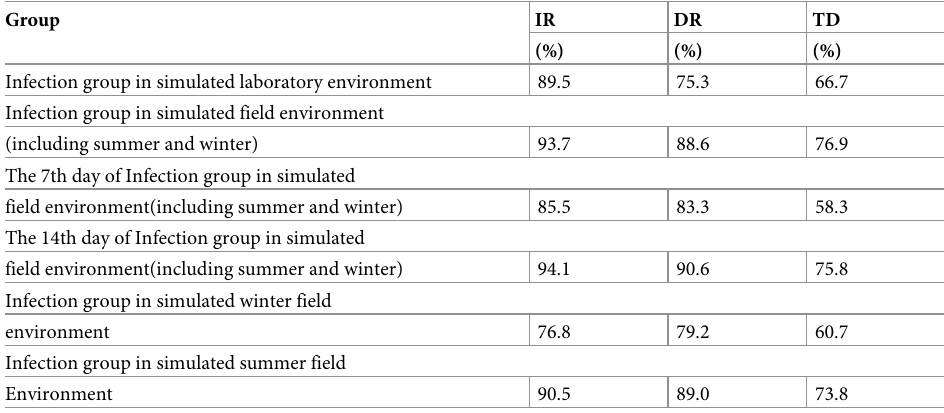
Table 5. Rates of dengue virus infection, dissemination, potential transmission, population potential transmis- sion by Ae . albopictus under different environment conditions.